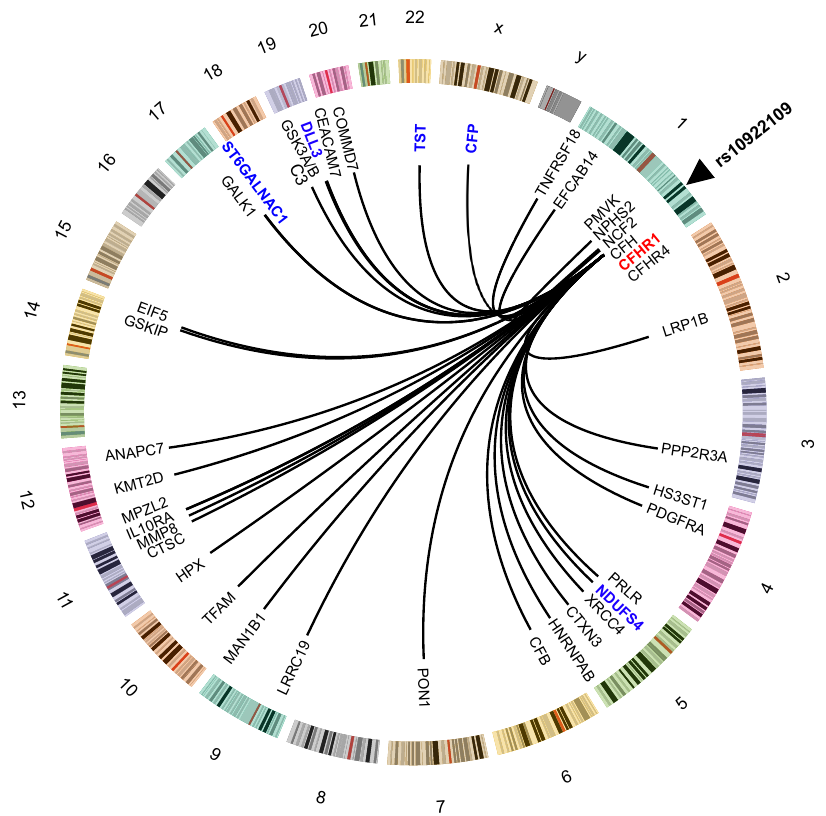
Fig. 5 Serum proteins link genetics to AMD. The Circos plot depicts the relationship between the AMD-associated variant rs10922109 at 1q31.3 and 40 serum proteins (see Supplementary Data 7 and 8 for details). The blue ( trans effects) and red ( cis effects) colored proteins are among the 28 AMD- associated proteins listed in Table